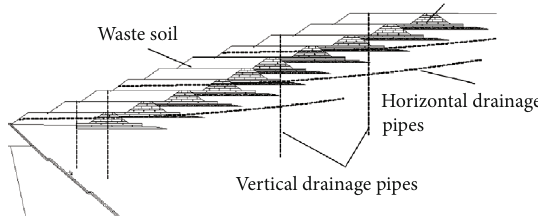
Figure 6: Design pro fi le of the dam